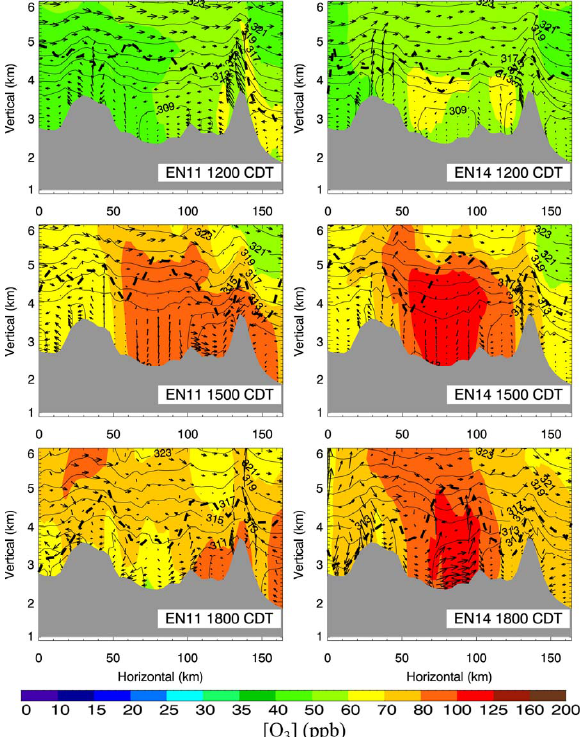
Fig. 9. Cross-section of [O 3 ] (ppb, shading), wind vectors, poten- tial temperature (K, contours), and PBL height (km, bold dash line) of two extreme members (EN-11 and EN-14) valid at 12:00 CDT, 15:00 CDT, and 18:00 CDT on 3 March 2006 along the cross line denoted in Fig.